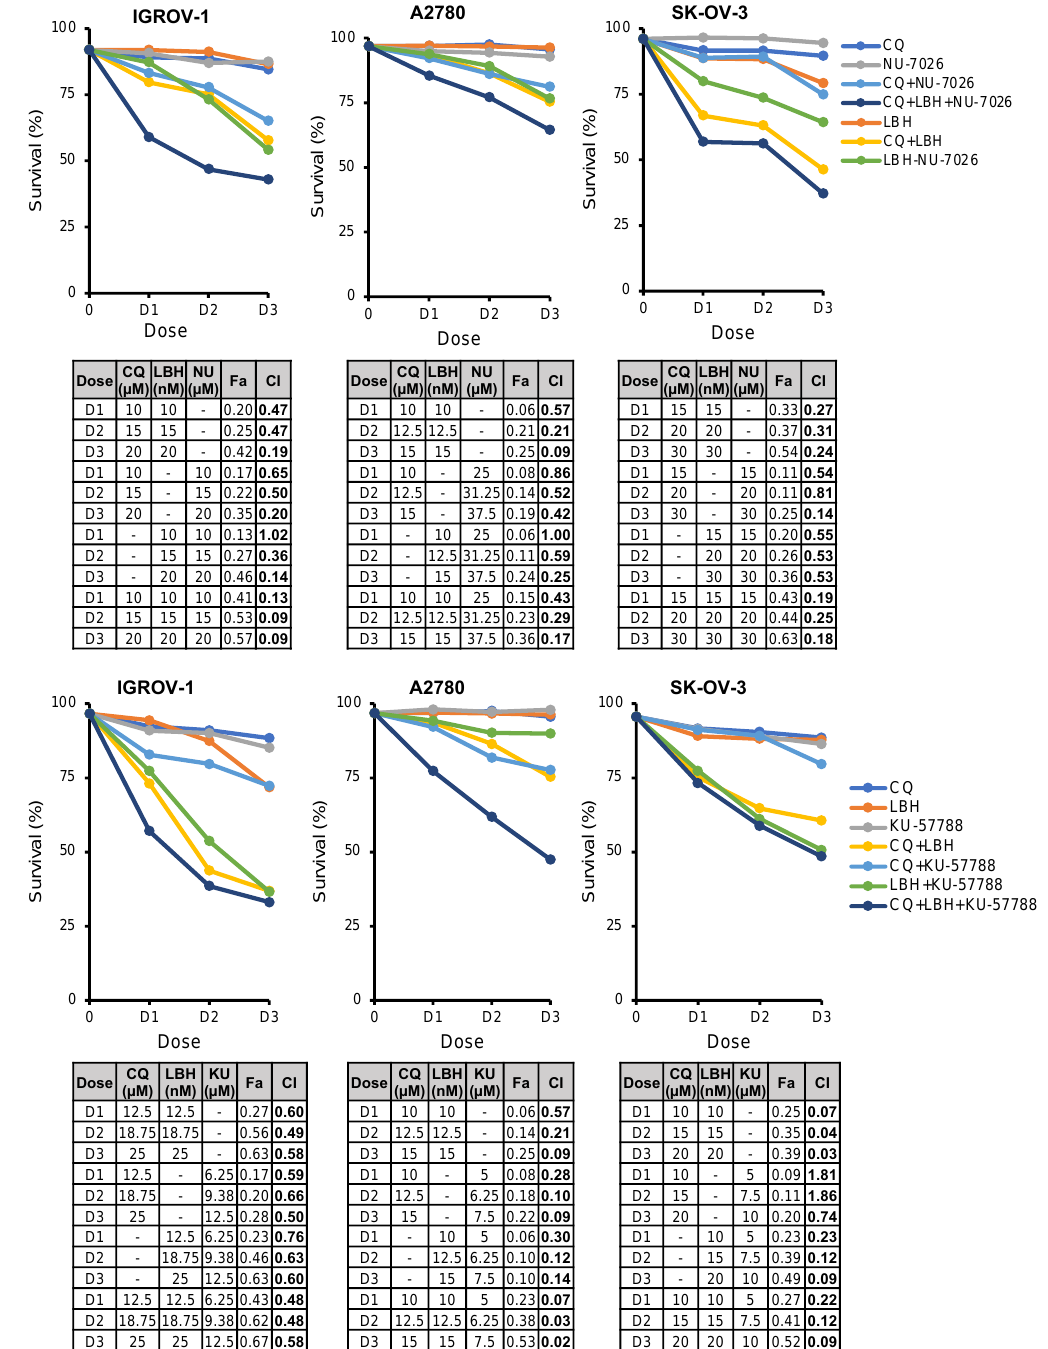
Figure 6. The triple-combination CQ-NHEJi-LBH exerts a more potent synergy than double combinations. Cells were exposed for 72 h to the indicated concentrations of LBH, CQ, and KU-57788/NU-7026 at a constant ratio, and the percentage of apoptotic cells was assessed by flow cytometry (after cell staining with annexin V and propidium iodide). CI values, calculated using Compusyn Software, are shown.